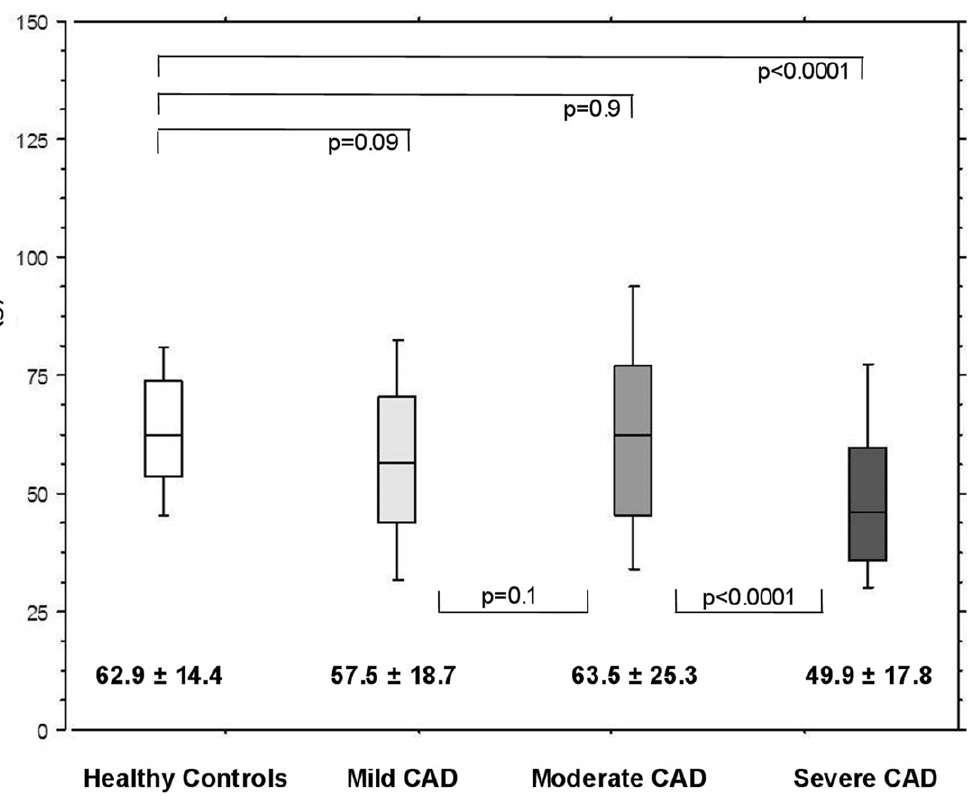
Figure 2. Relationship between EAT and atherosclerosis severity in the whole study population. The box plots illustrate the EAT mass in healthy controls (white box plot), patients with mild CAD (GSS # 10, light gray box plot), moderate CAD (GSS . 10 2# 40, dark gray box plot) and severe CAD (GSS . 40, black box plot). EAT mass is given as mean 6 standard deviation below the box plots, the line in the box plots indicates the median value of the data. The p-values for the comparison of the groups are also indicated. The figure shows that the EAT mass was comparable between healthy controls and CAD patients with mild and moderate CAD. However, in patients with severe CAD, a significant decrease in EAT mass compared to patients with moderate CAD and healthy controls could be detected. Abbreviations: CAD: coronary artery disease, EAT: epicardial adipose tissue, GSS: Gensini score.